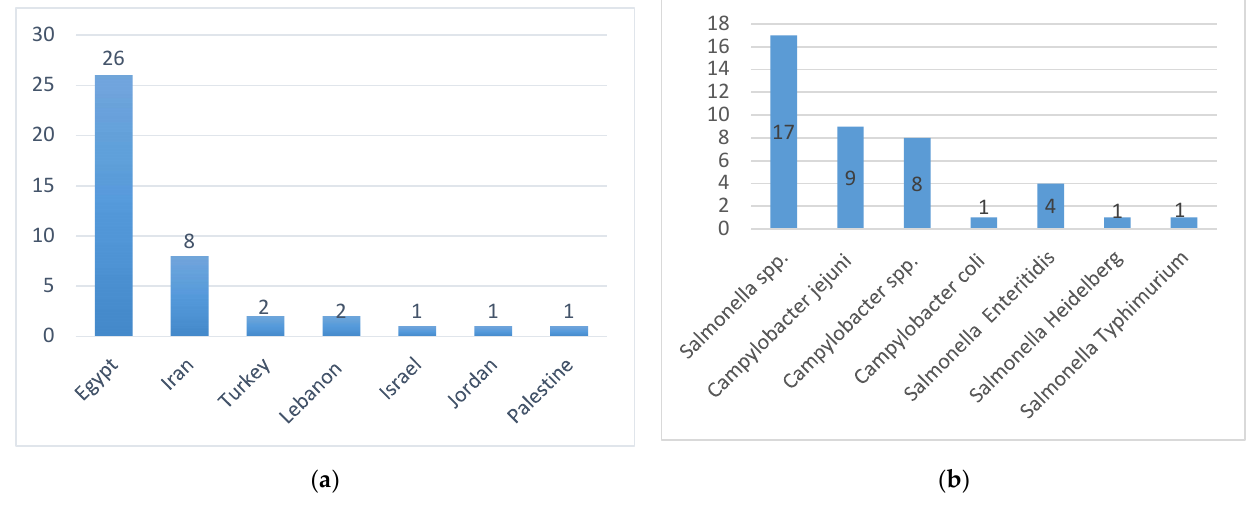
Figure 2. : Number of studies ( a ) per country and ( b ) per pathogen. Figure 2. Number of studies ( a ) per country and ( b ) per